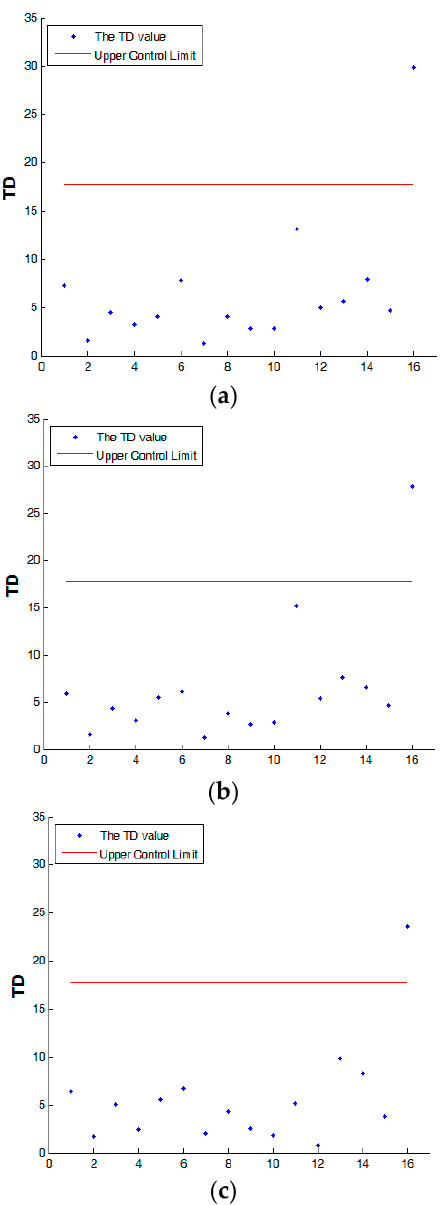
Figure 8. Detect the abnormal profiles using the polynomial model with the 16 profiles (fifteen in-control and one out-of-control for each scenario). ( a ) Detecting the abnormal profile 1; ( b ) Detecting the abnormal profile 2; and, ( c ) Detecting the abnormal profile 3.